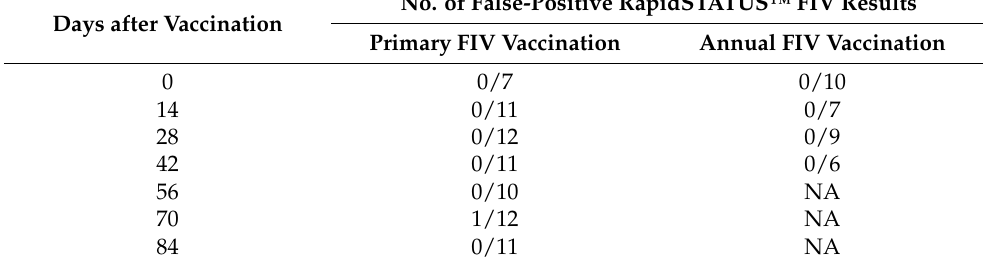
Table 2. Results from RapidSTATUS™ FIV testing in FIV-vaccinated/FIV-uninfected cats in Australia. Cats were either administered a primary FIV vaccination course (3 vaccines on days 0, 28, and 56), or an annual booster FIV vaccination (1 vaccine on day 0). NA = not available. No. of False-Positive RapidSTATUS™ FIV Days after Vaccination